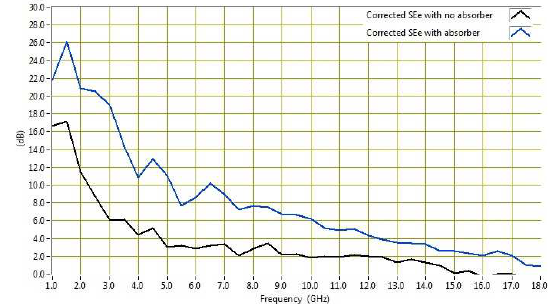
Figure 7: Enclosure made with metallic mesh of 1 mm side dimension. Difference between the SE e with the absorber (blue line) and without it (black line) inside the